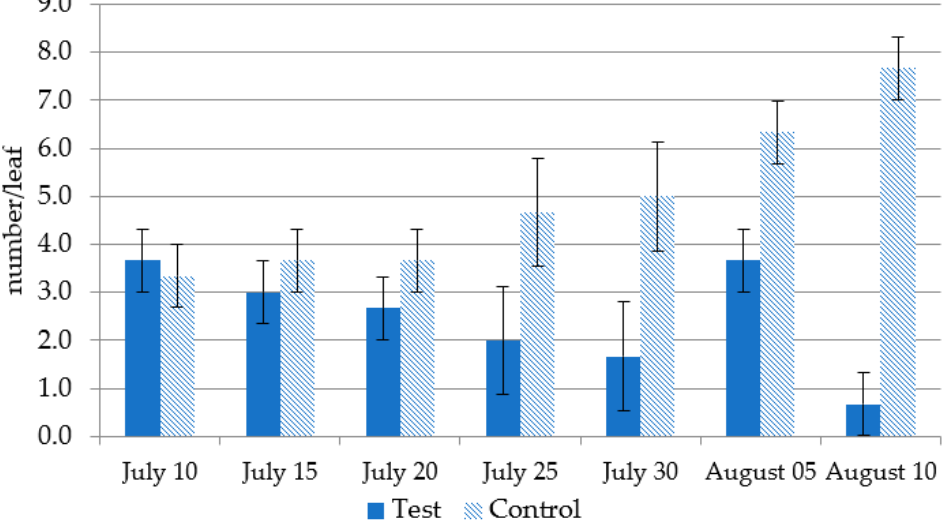
Figure 4. Change in the number of herbivorous mites due to the introduction of predatory phytoseiidae mites on an apple tree in 2021.